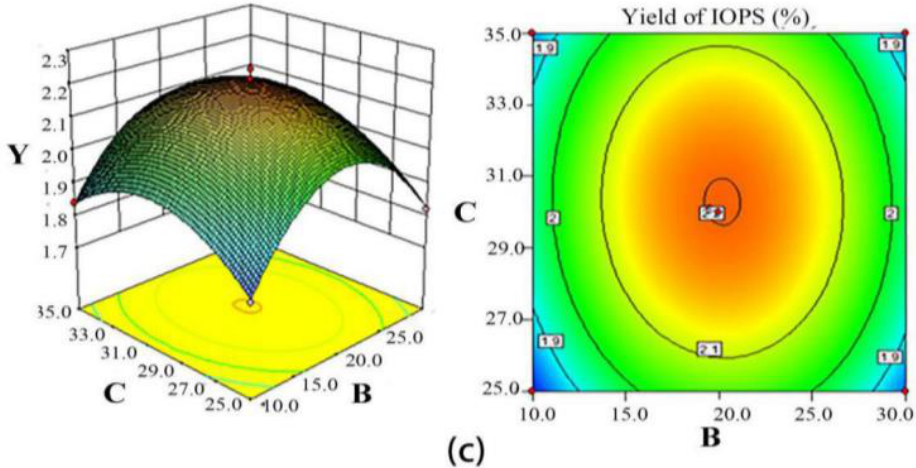
Figure 3. Response surface and contour plots showing ( a ) the effects of mass fraction of (NH 4 ) 2 SO 4 (A, %) and amount of t -butanol (B, mL) on the EY of IOPS (Y, %); ( b ) the effects of mass fraction of (NH 4 ) 2 SO 4 (A, %) and temperature (C, °C) on the EY of IOPS (Y, %); and ( c ) the effects of the amount of t -butanol (B, mL) and temperature (C, °C) on the EY of IOPS (Y, %).